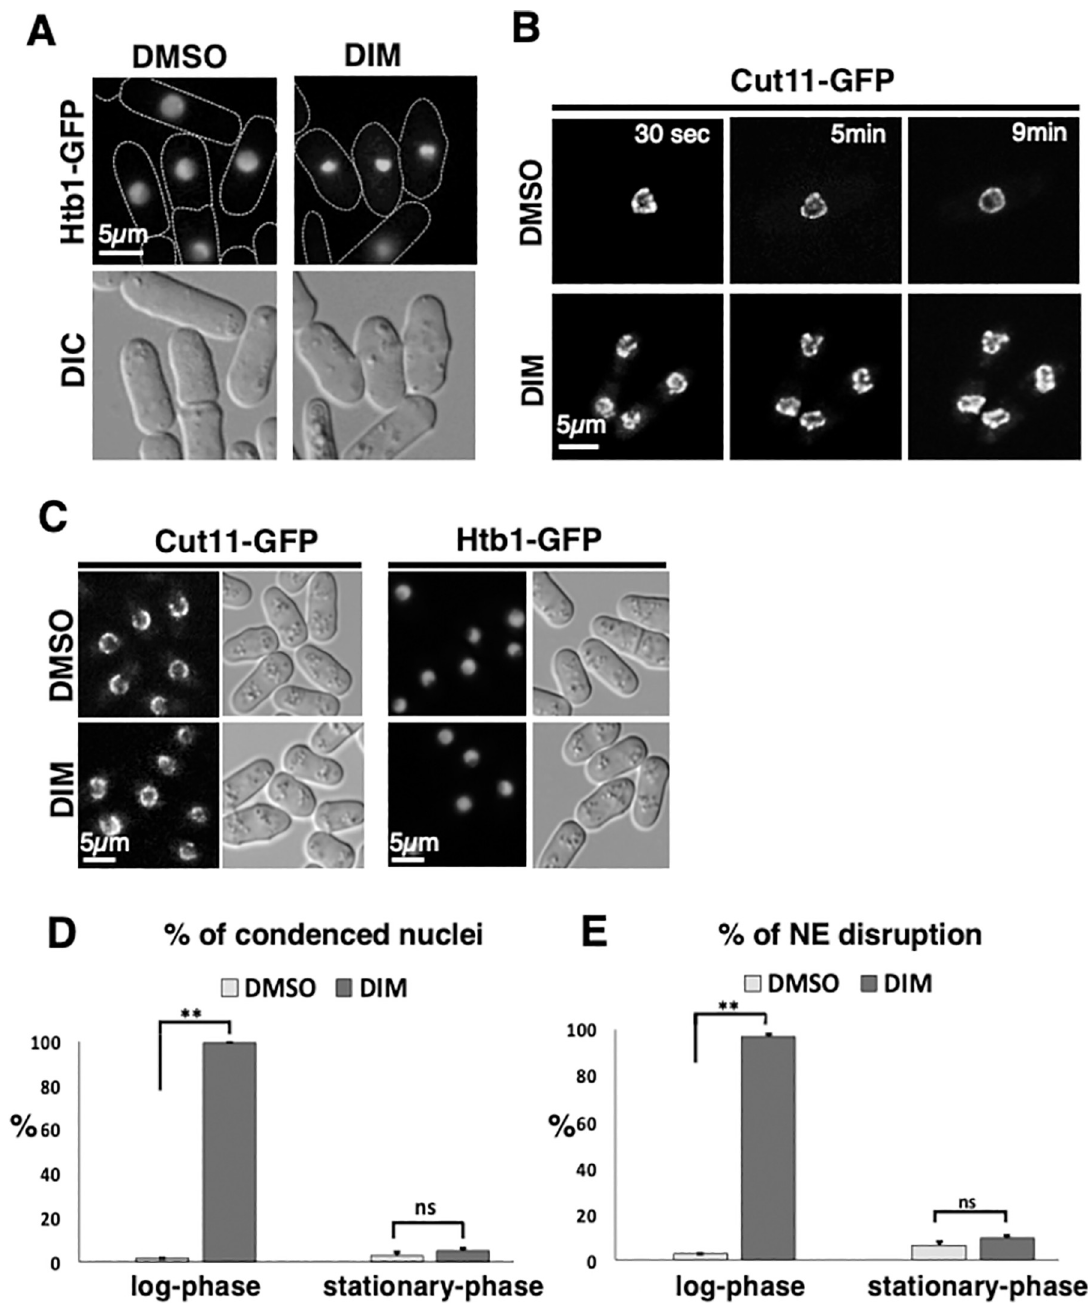
Fig 4. DIM induces nuclear condensation and NE disruption in log-phase cells. (A) 20 μ g/ml 3,3’-Diindolylmethane (DIM) was added to log-phase cells (0.5 〜 1 x 10 7 cells/ml) expressing Htb1-GFP as a histone marker. Images taken after 10 min of incubation with DIM and DMSO are shown. (B) The time-lapse images of Cut11-GFP signal used as a marker for nuclear envelope (NE) are shown. Time after 20 μ g/ml DIM addition to log-phase cells is shown. (C) 20 μ g/ml DIM was added to the stationary-phase cells (10 〜 15 x 10 7 cells/ml) that are cultured as in Fig 1C. After 10 min, the shape of the nuclei and NE were observed as in A and B. (D and E) The percentages of condensed nuclei in D and disrupted NE in E are shown for treated cells in A-C. At least 200 cells were counted with three independent experiments for D and E